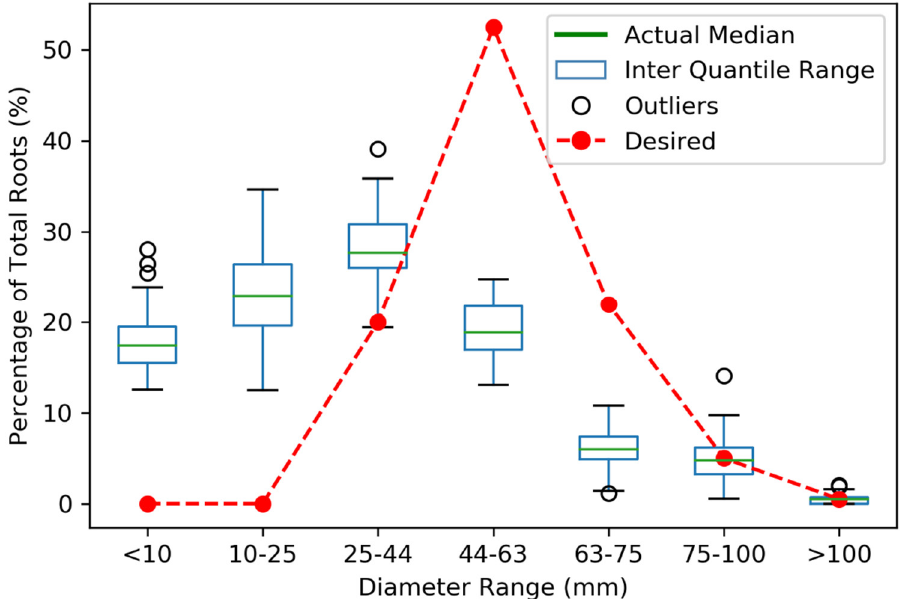
Figure 11. The median percentage of all 2018 plots’ table beet roots, falling in each diameter range, are plotted in green inside of a box spanning the inter quantile range (IQR). Outliers are marked with black open circles and fall outside the error bars located at Quantile 3 + 1.5 IQR (above) and Quantile 1–1.5 IQR (below). The optimal percentages of table beet roots falling in each range, as provided by Love Beets USA (a commercial beet grower), is plotted with red filled circles.